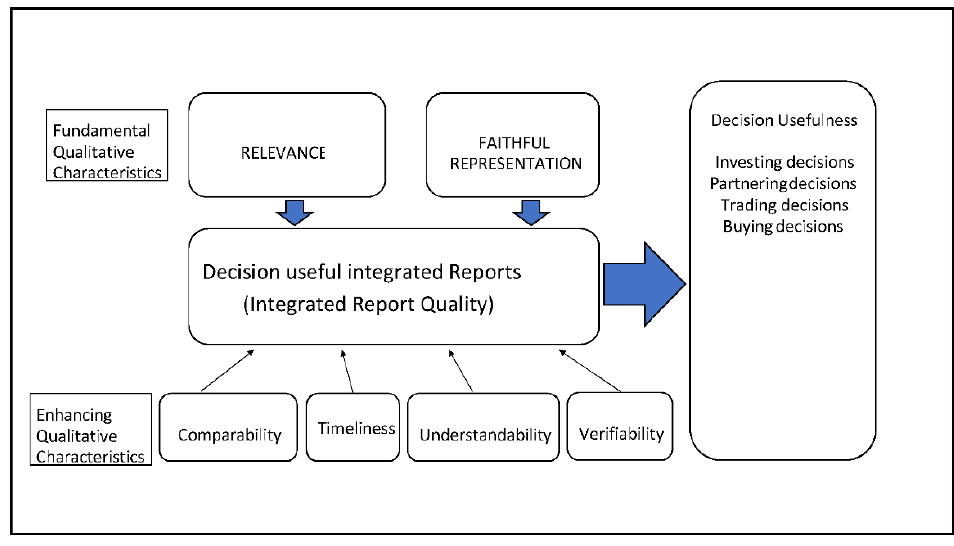
Figure 1. The Qualitative Characteristics of Financial Reporting. Source —Authors’ own illustration .